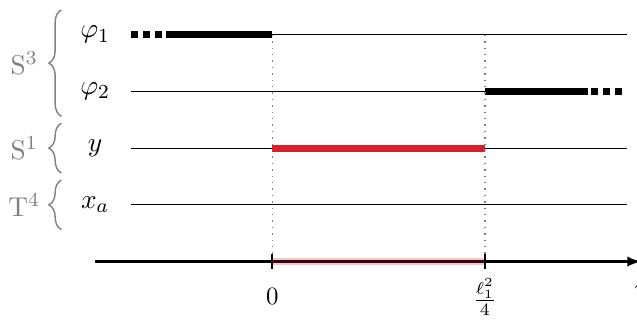
Figure 2 . Rod diagram of the shrinking directions on the z -axis after sourcing the solutions with one rod that forces the degeneracy of the y -circle. We took the figures of [52] as